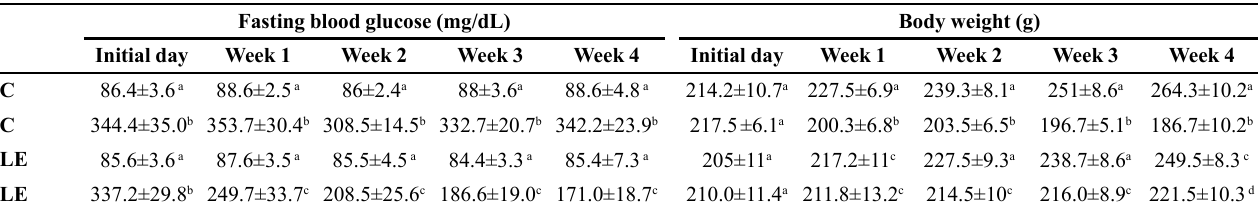
TABLE II - Fasting blood glucose level (mg/dL) and body weight (g) after four weeks of administration of Lycium europaeum extract in normal and alloxan- diabetic